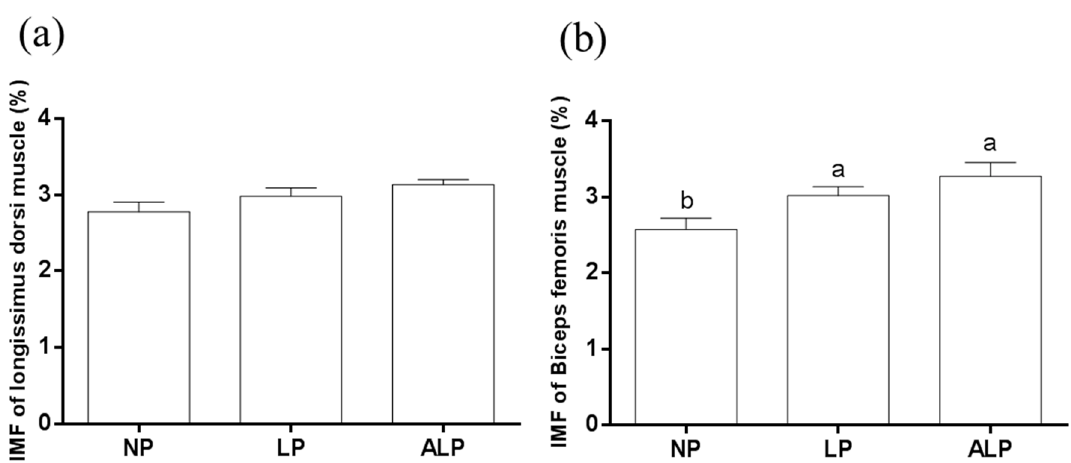
Figure 1. E ff ects of dietary AKG supplementation of a low crude protein diet on intramuscular fat (IMF) in the longissimus dorsi ( a ) and biceps femoris ( b ) muscles of growing pigs. Results are means ± SEM, representing nine animals per treatment. Bars without a common letter di ff er significantly ( p < 0.05). NP, normal protein; LP, low crude protein; ALP, AKG + low crude protein.